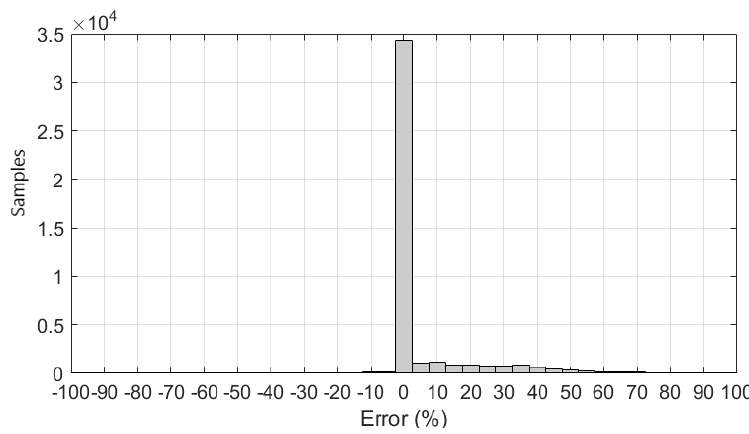
Figure 10. Difference between 100 MW, 3 h BESS power output and AGC commands for 18 GW of wind power